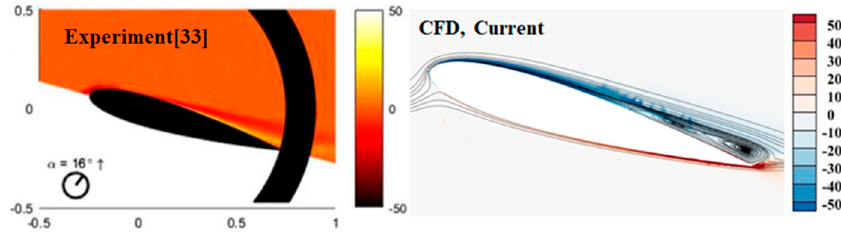
Figure 6. Flow patterns around the baseline NACA 0015 airfoil.